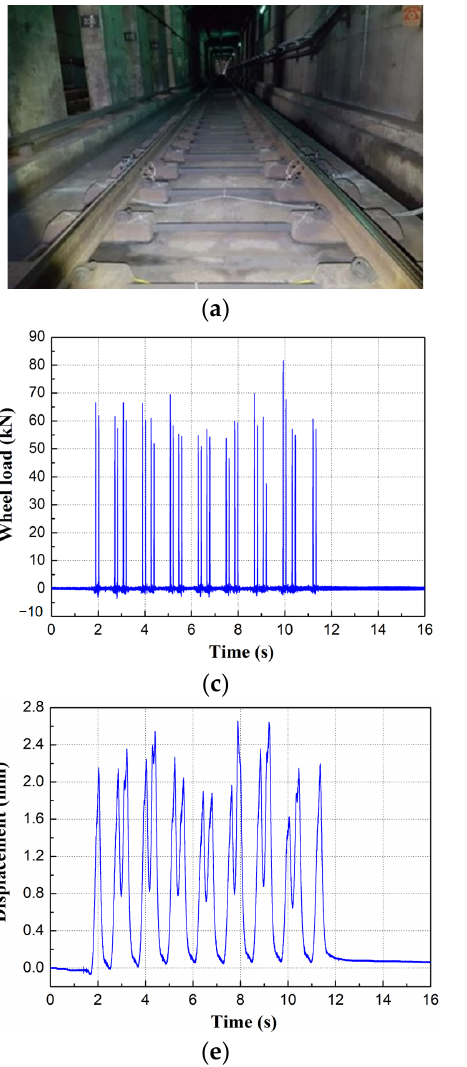
Figure 3. Field test setup and examples of collected data: ( a ) view of the test area; ( b ) measurement setup; ( c ) example of the measured dynamic wheel load; ( d ) example of the measured lateral wheel load; ( e ) example of the measured RC sleeper vertical displacement; ( f ) distribution of wheel load and RC sleeper displacement measurements.